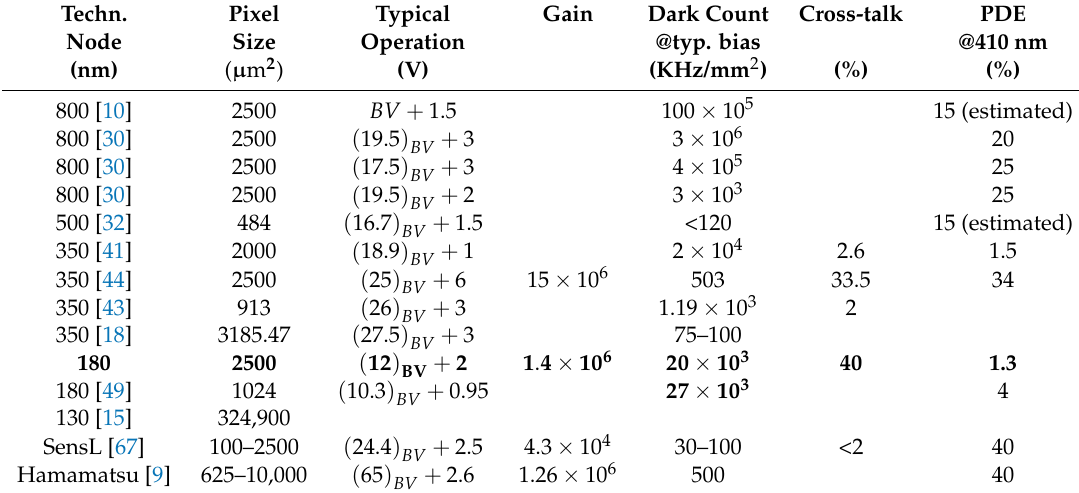
Table 1. Comparison of the results obtained in this paper, using a 180 nm GF BCDLite CMOS process (in bold), with a selection of SiPMs obtained with standard CMOS technologies (upper part) and with custom-technology (lower part). The breakdown voltage (BV), gain, dark count rate and photon detection efficiency (PDE) at 410 nm are shown when